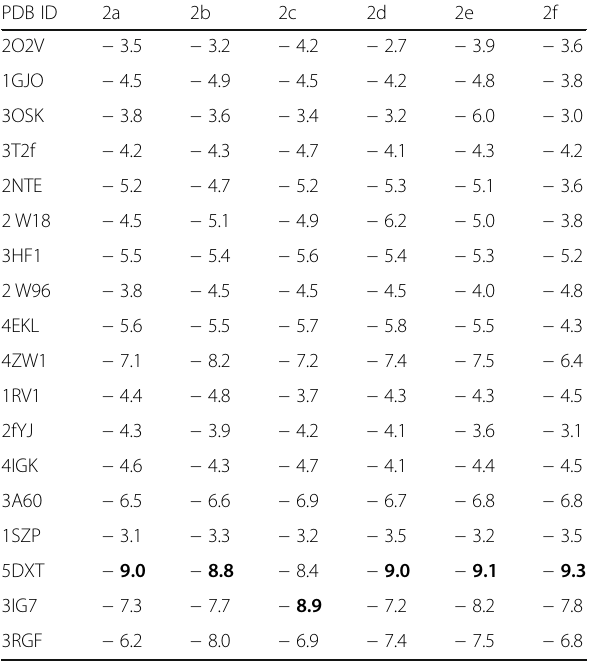
Table 2 Schrödinger Maestro Docking score (kcal/mol) of compounds against selected up regulated proteins in BC PDB